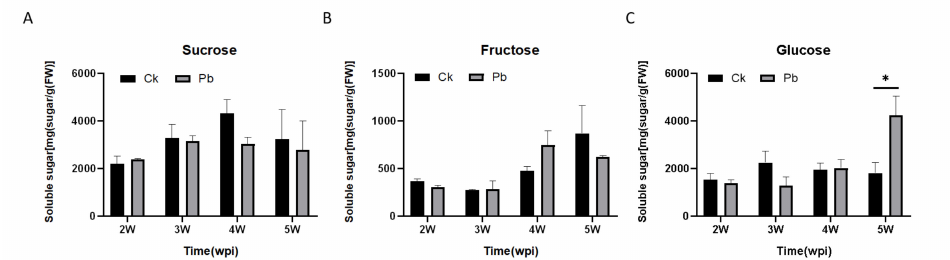
Figure 1. Sugar content in the roots of Chinese cabbage after Plasmodiophora brassicae infection. ( A ), Sucrose, ( B ), Fructose, ( C ), Glucose. Ck, inoculation with distilled water; Pb, inoculation with P. brassicae . FW, Fresh weight. The horizontal axis represents the time point from 2 to 5 weeks post-inoculation (wpi), and the ordinate represents the value of the sugar content. The results are means ± SEs from three independent biological repeats. The asterisks indicate p -values (* p < 0.05) according to Student’s t -test. The horizontal axis is the time point from 2 to 5 weeks post-inoculation (wpi) independent biological